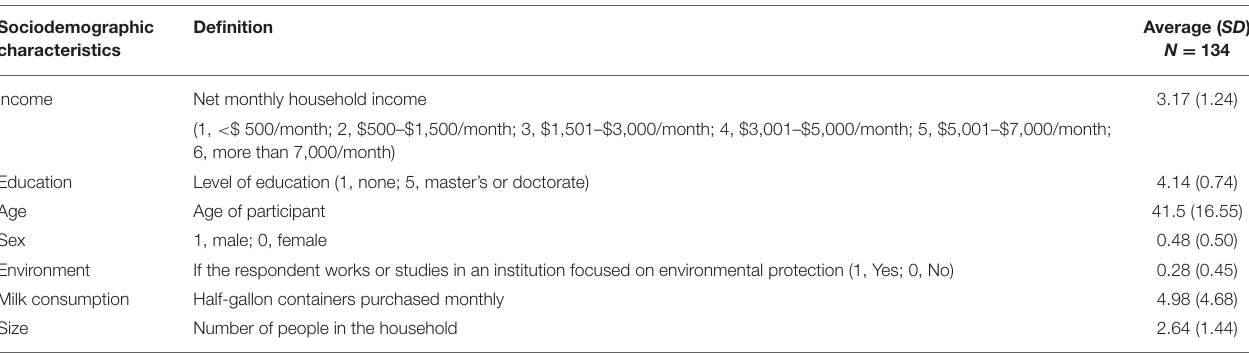
TABLE 2 | Sociodemographic profile of the participants. Sociodemographic characteristics